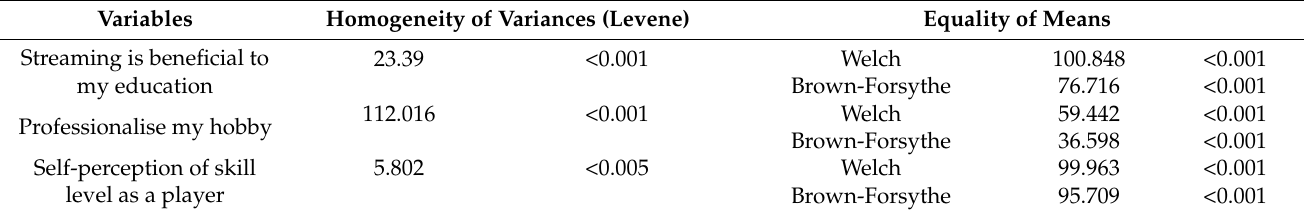
Table 6. Robust tests of homogeneity of variance and equality of means for perception